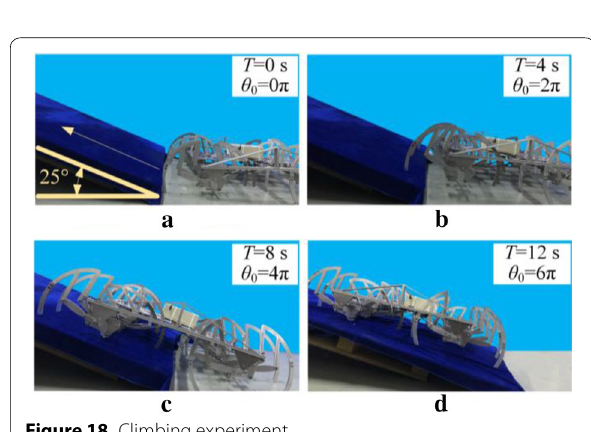
Figure 18 Climbing experiment